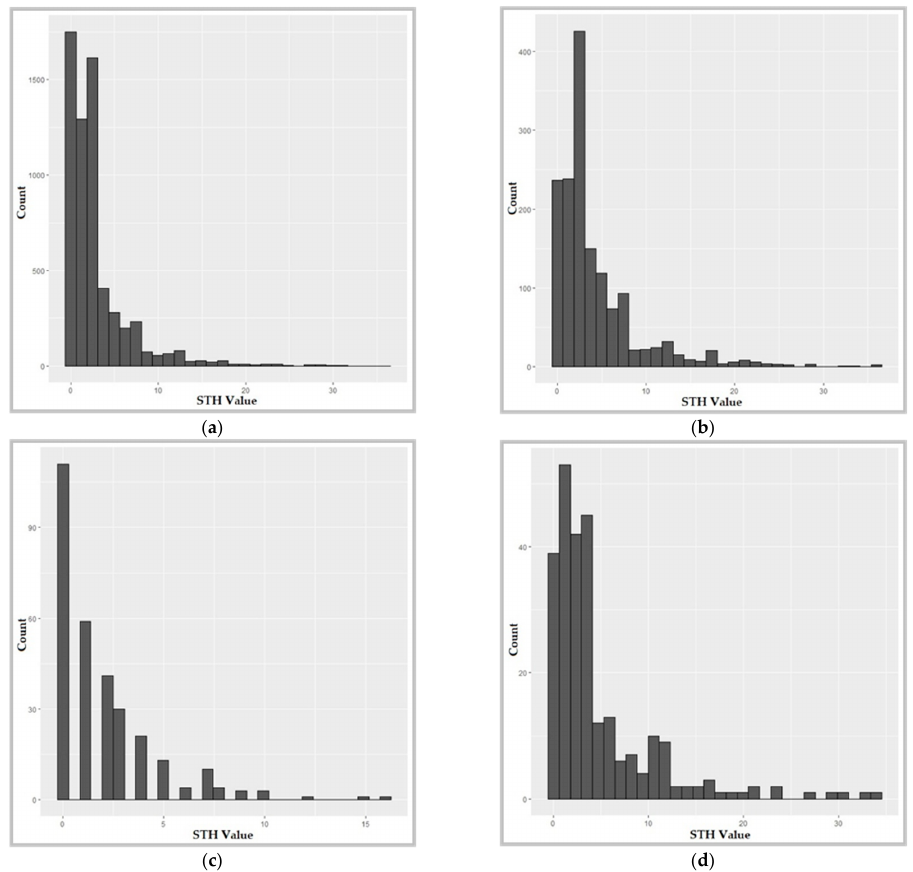
Figure A1. Distribution of each case study’s set of surface spatio-temporal heterogeneity (STH) values. ( a ) The NAA case study area; ( b ) The NBA case study area; ( c ) The CSR case study area; ( d ) The IFF case study area.